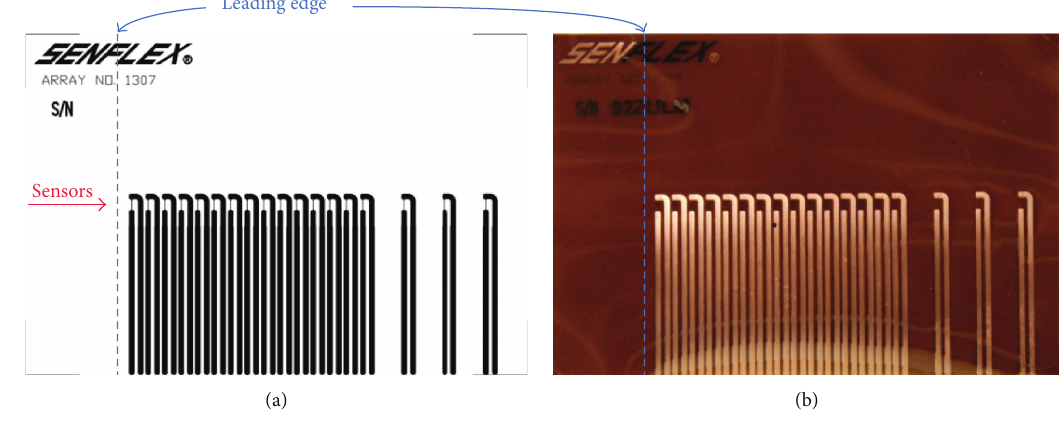
Figure 1: Hot-film sensor array: (a) drawing and (b)